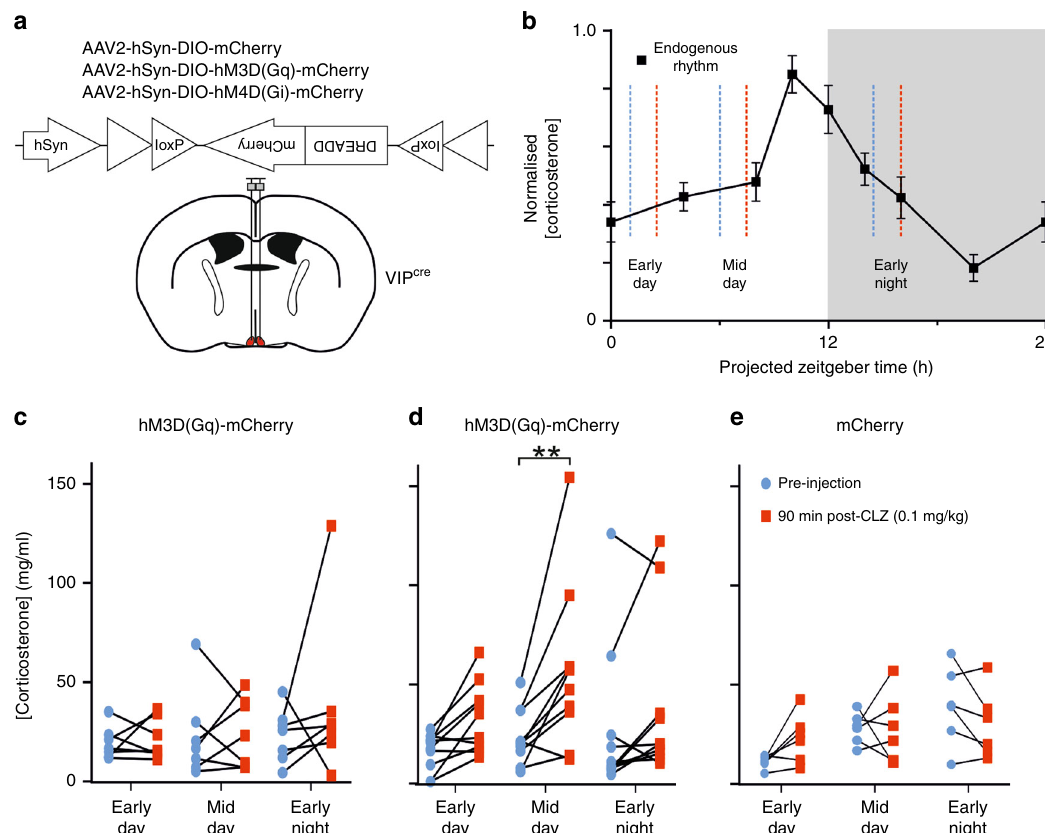
Fig. 6 Chemogenetic inhibition of SCN VIP cells modulates circulating corticosterone concentrations. a Schematic showing the viral constructs delivered bilaterally to the SCN of VIP + /cre mice. b Normalised daily changes in corticosterone concentration for wild type animals ( n = 12; mean ± SEM) with schematic indication of epochs used for analysis of response to DREADD-based manipulation: tail bleed samples were taken immediately prior to injection of clozapine (CLZ; 0.1 mg/kg) and 90 min post-injection (blue and red dotted lines respectively) over three different time-points. Testing across each of the three indicated time-points was separated by at least 5 days. c – e Circulating corticosterone concentrations prior to- and following clozapine injection in Gq- ( c ; n = 7), Gi-DREADD ( d ; n = 10) and mCherry ( e ; n = 6) animals. Data were analysed by two-way RM ANOVA ( c ; CLZ: F 1, 6 = 0.66, P =